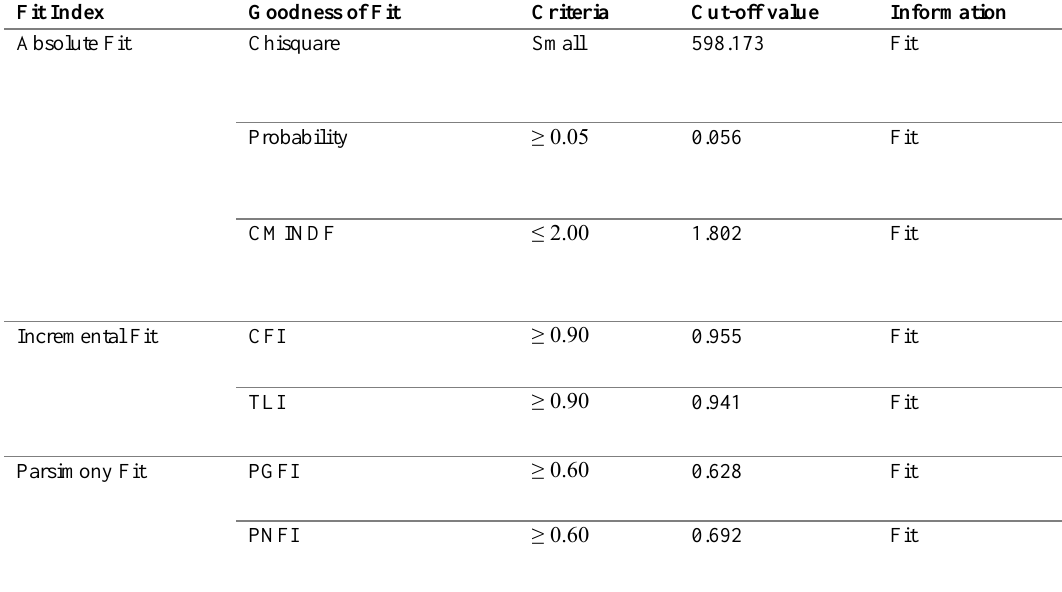
Table 2: Value of Goodness of